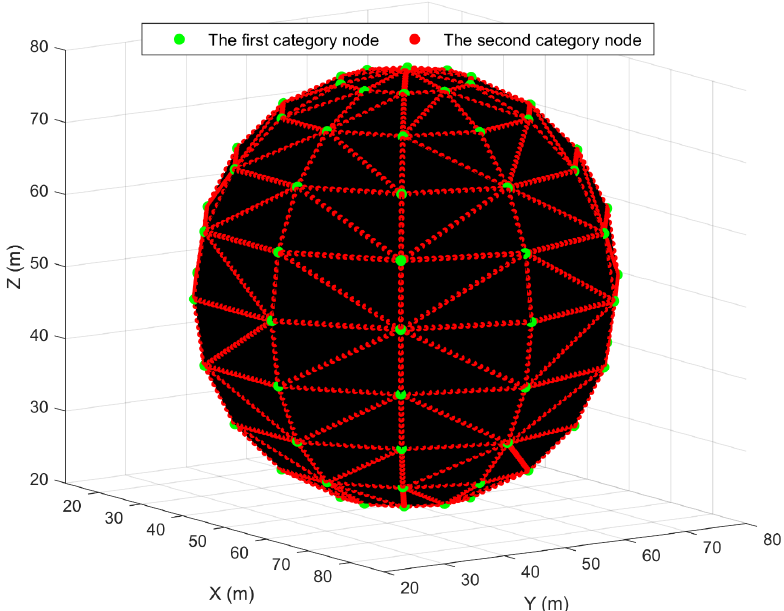
Figure 7. A void model and nodes layout. The green circle and the red circle represent the first category of nodes (vertex) and the second category of nodes,